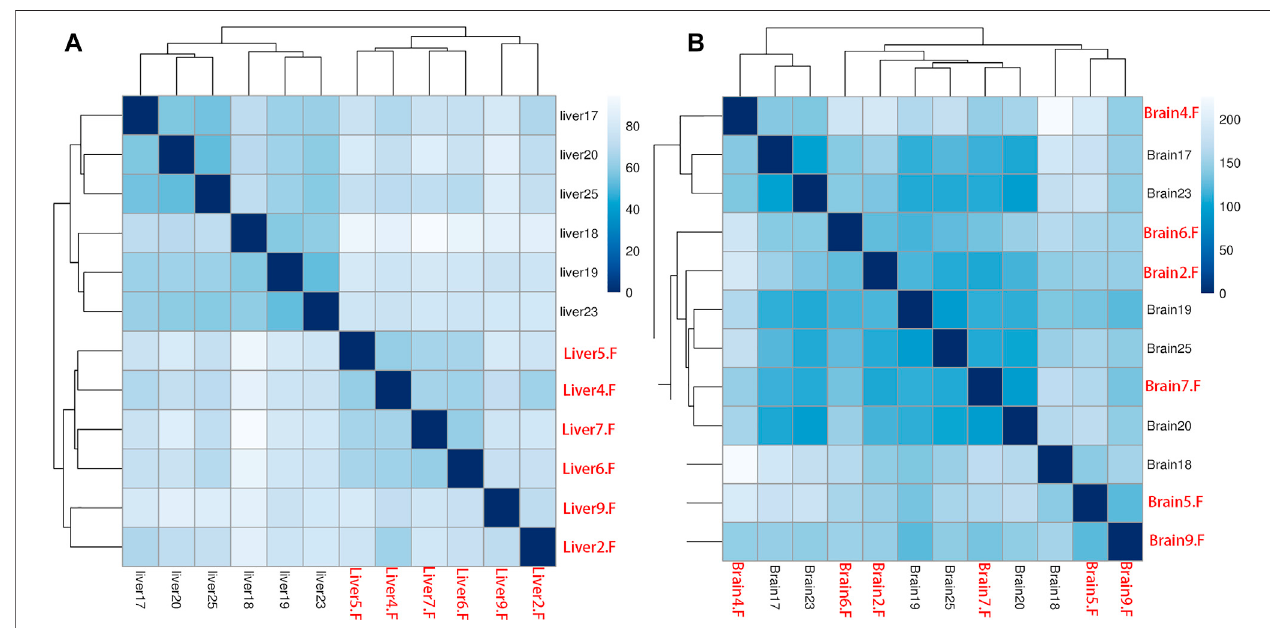
FIGURE 1 | Person ’ s correlation for all samples in liver (A) and brain (B) tissues based on gene expression. All female samples are colored with red and all male samples are colored with